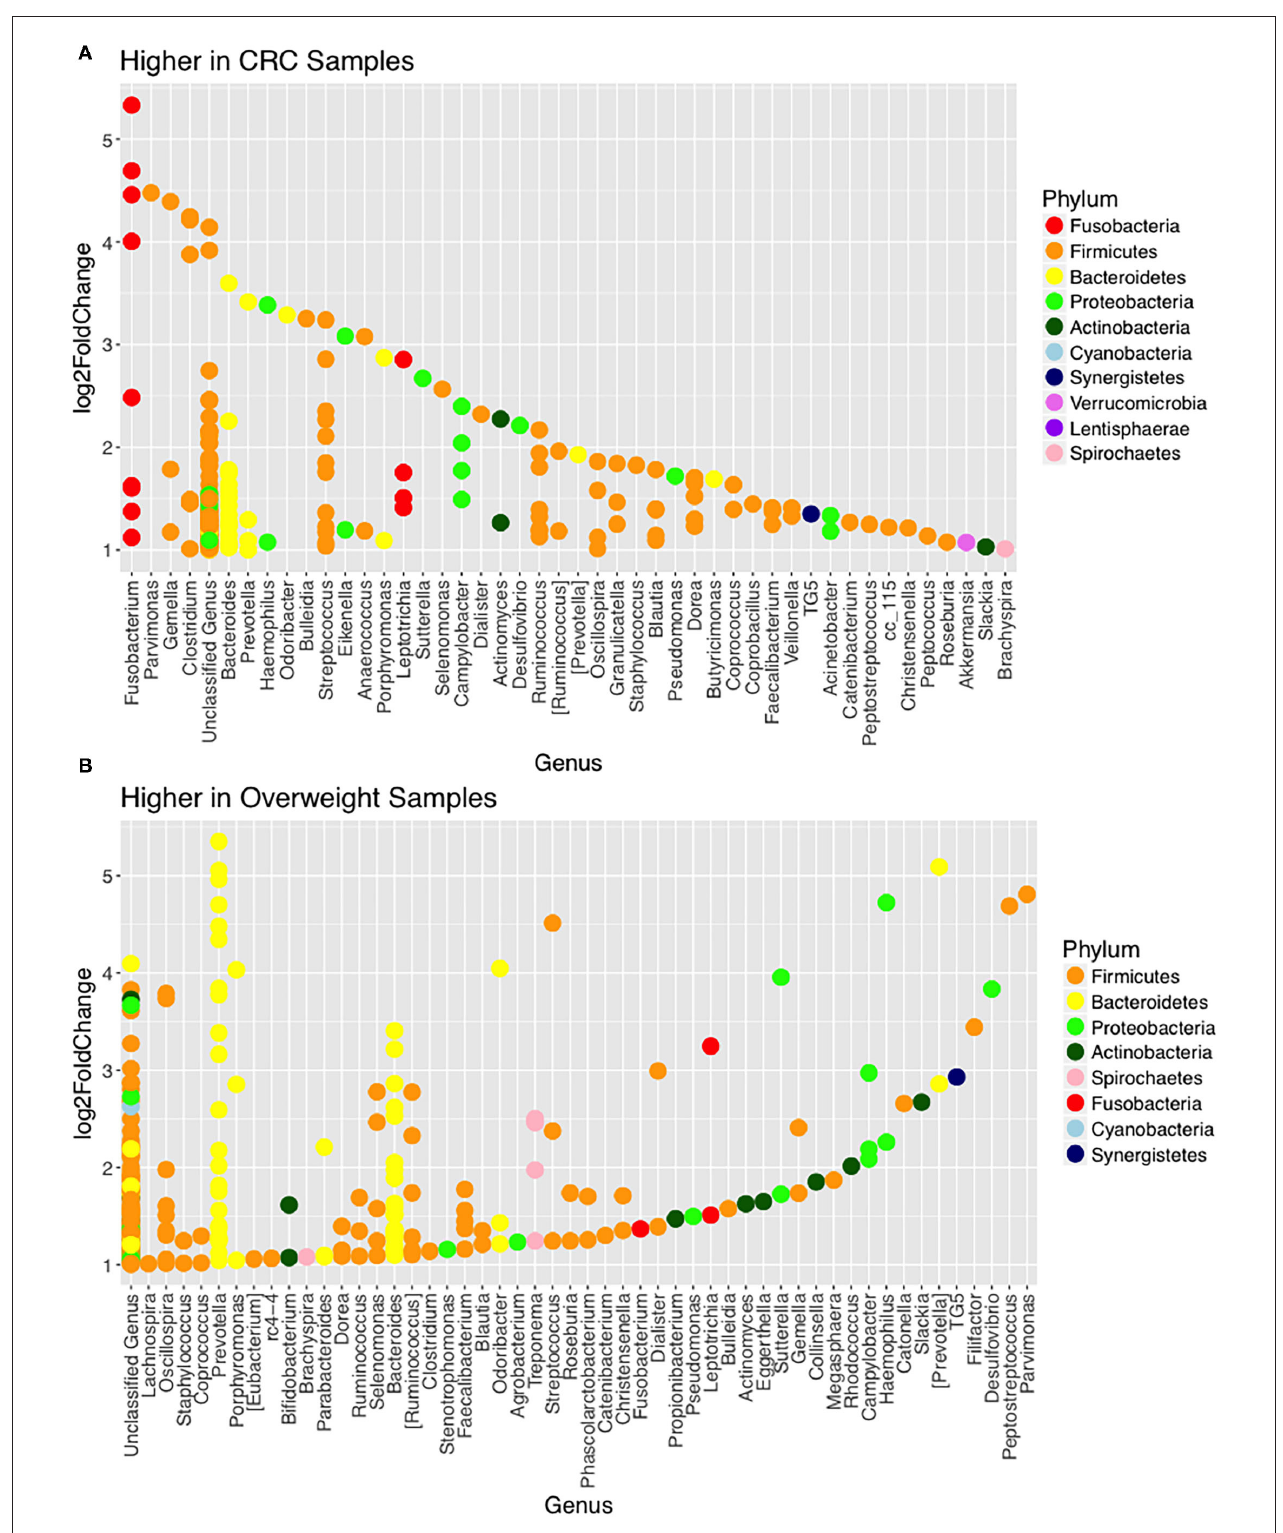
FIGURE 3 | Changes in relative abundance of operational taxonomic units (OTUs). (A) OTUs with LogFC > 1 with higher abundance in CRC samples (when compared with adjacent normal samples) including Fusobacterium (adj p = 0.014; DESeq2) and (B) OTUs with LogFC > 1 with higher abundance in overweight samples (when compared with healthy weight), in the CRC patient cohort, including Prevotella copri (adj p = 0.042; DESeq2).